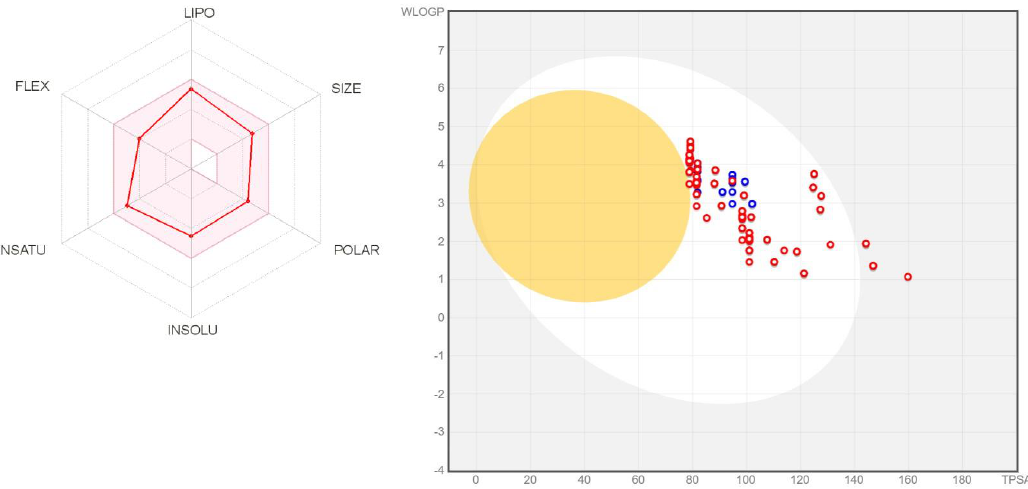
Figure 7. Results of the absorption, distribution, metabolism, and excretion (ADME) assessment. Left panel: consensus values for a single compound ( CCmI ). Right panel: BOILED-Egg graph [43] illustrating good gastrointestinal absorption (white area).